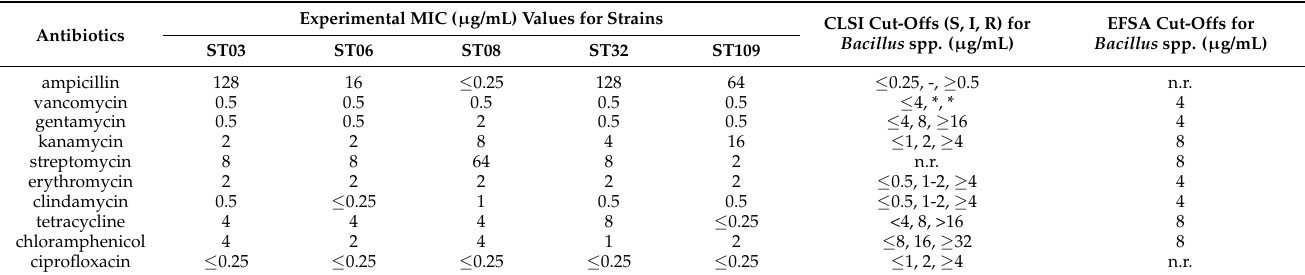
Table 5. Antibiotic susceptibility for B. velezensis ST03, B. amyloliquefaciens ST06, B. subtilis ST08, B. velezensis ST32, and B. amyloliquefaciens